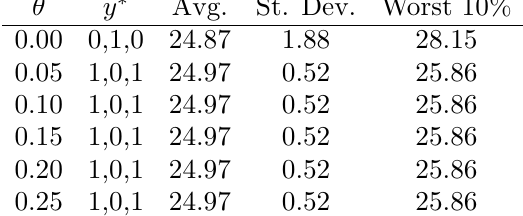
Table 6. Summary results for